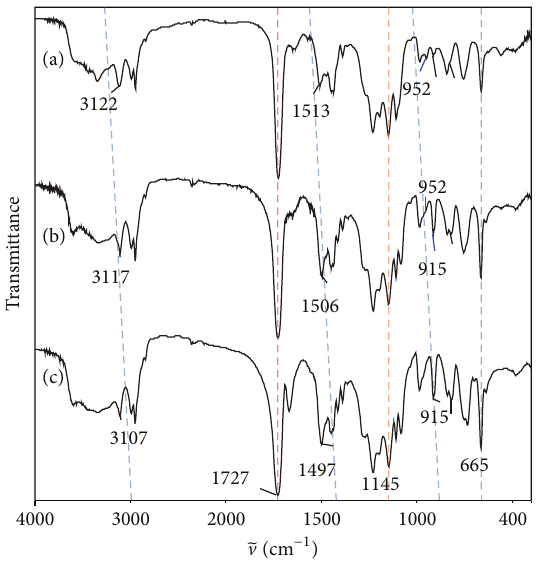
Figure 1: FTIR spectra of PVM-44 (c) coordinated by Cu 2+ (a) or Zn 2+ (b) [47]. As a result of complexation, some FTIR bands of the imidazole (marked blue) are shifted, in particular the in-plane skeletal vibrations of the imidazole ring. However, the carbonyl stretch of the MMA methylester (marked red) remains unaltered.